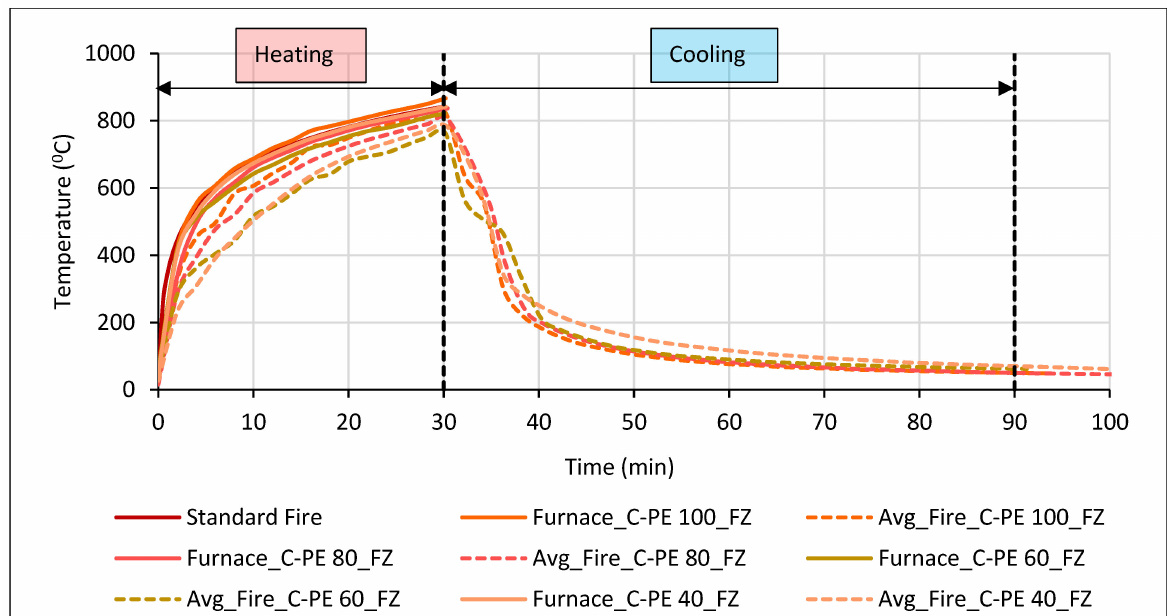
Figure 23. Furnace and fire side surface time–temperature curves of C-PE blocks from the bushfire